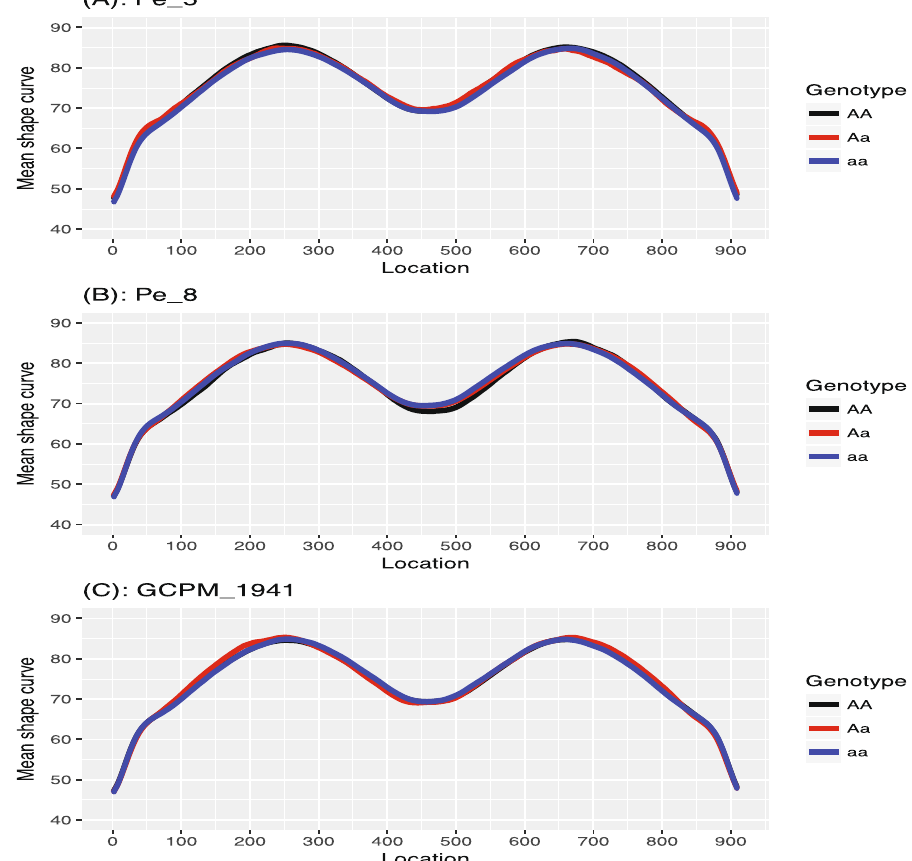
Figure 7. The average of the predicted shape curves output from the FunFor approach across all observations belong to each genotype category for the three least important markers Pe_5 , Pe_8 , and GCPM_1941 . The black curve for AA, the red curve for Aa, and the blue curve for